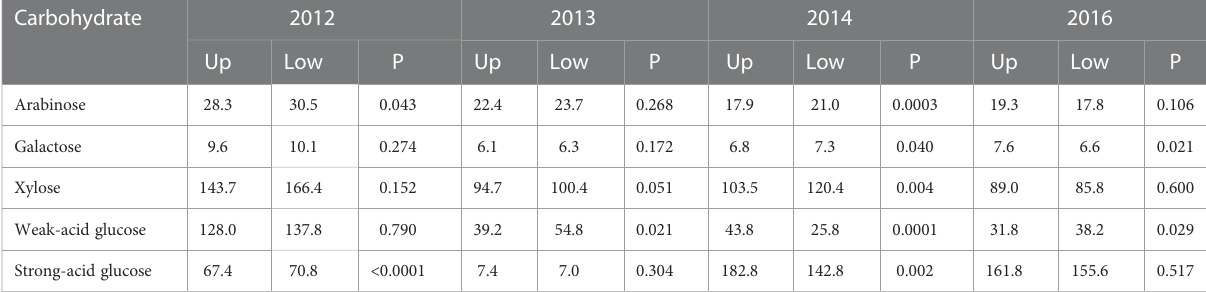
TABLE 3 Landscape means, averaged across the control and two humic product treatments, for concentrations of carbohydrate compounds (g kg -1 ) in maize stover, shown for four years for the upland (Up) and lowland (Low) transects, and the signi fi cance (P) of the landscape effect.